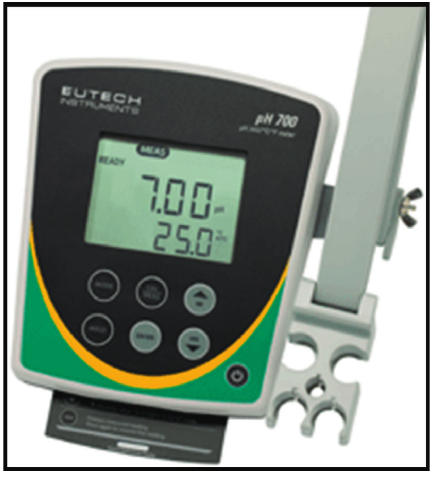
Figure 1: pH 700 meter.